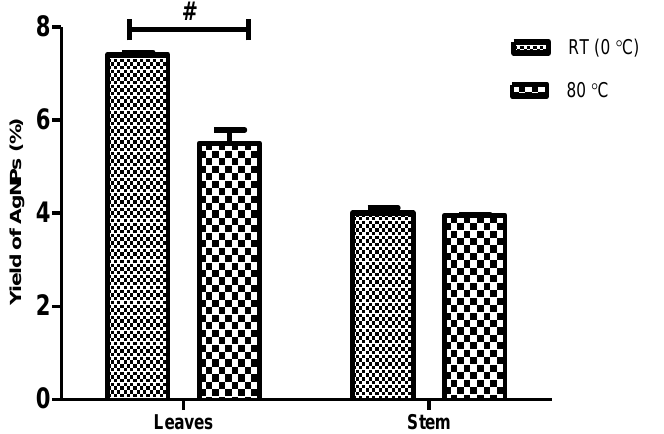
Figure 1. Percentage yield of AgNPs obtained from leaves and stem bark of D. villosa at room temperature (RT) and at 80 ◦ C. F (1,8) = 33.94. # (Leaves RT vs. Leaves 80 ◦ C), p < 0.001.